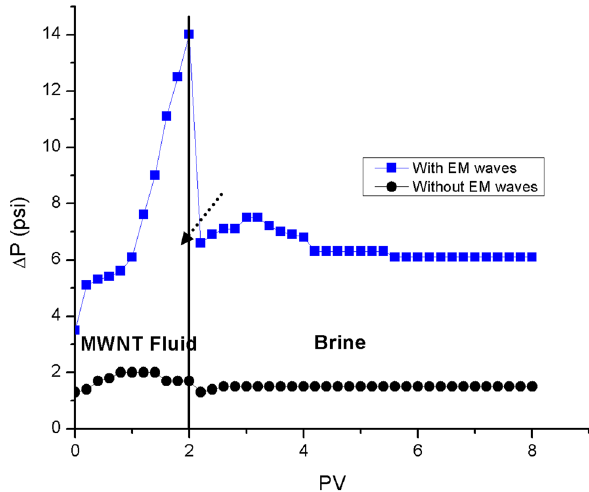
Fig. 4 Comparison of pressure versus pore volume of MWCNT fluid injected in the absence and presence of EM